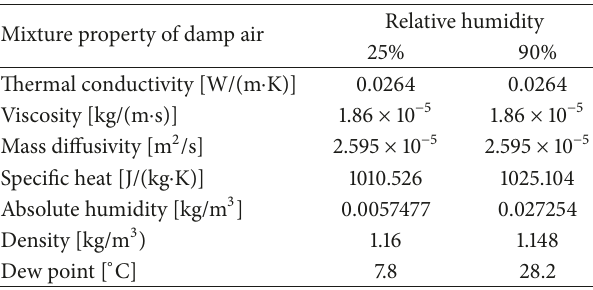
Table 2: Material properties for water vapor condensation UDF [11,